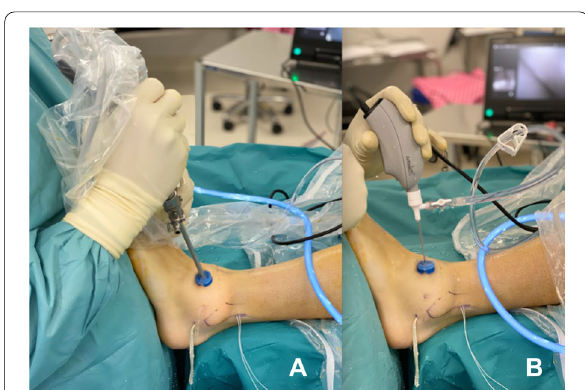
Fig. 1 Standard arthroscope being replaced by the NanoScopeTM. A Standard arthroscope in the anterolateral portal. B NanoScopeTM in the anterolateral portal